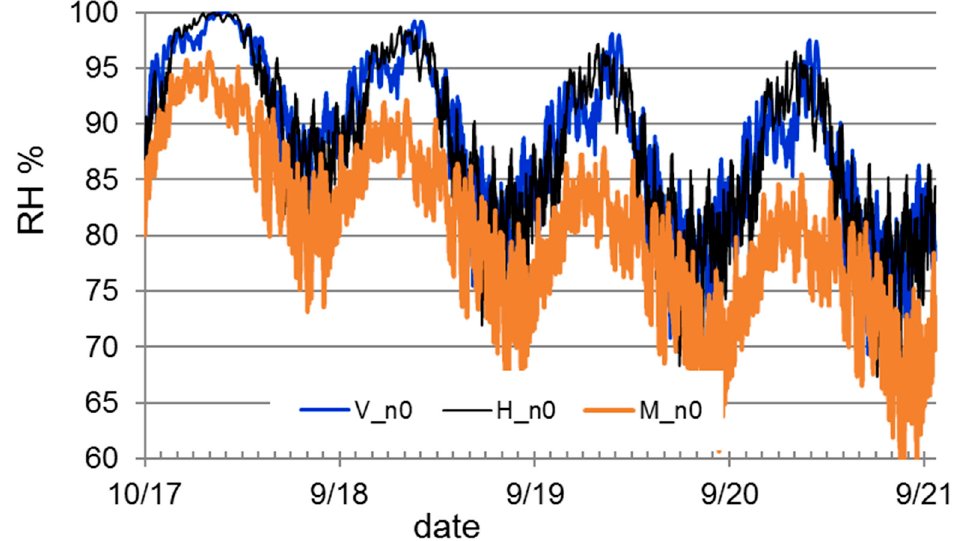
Figure 10. Brick wall, no ventilation, normal dry initial conditions (80% RH). The relative humidity in the boundary between mineral wool back layer insulation and the polyurethane (PU)-insulation of the panel in three different climates during the four-year simulation period.